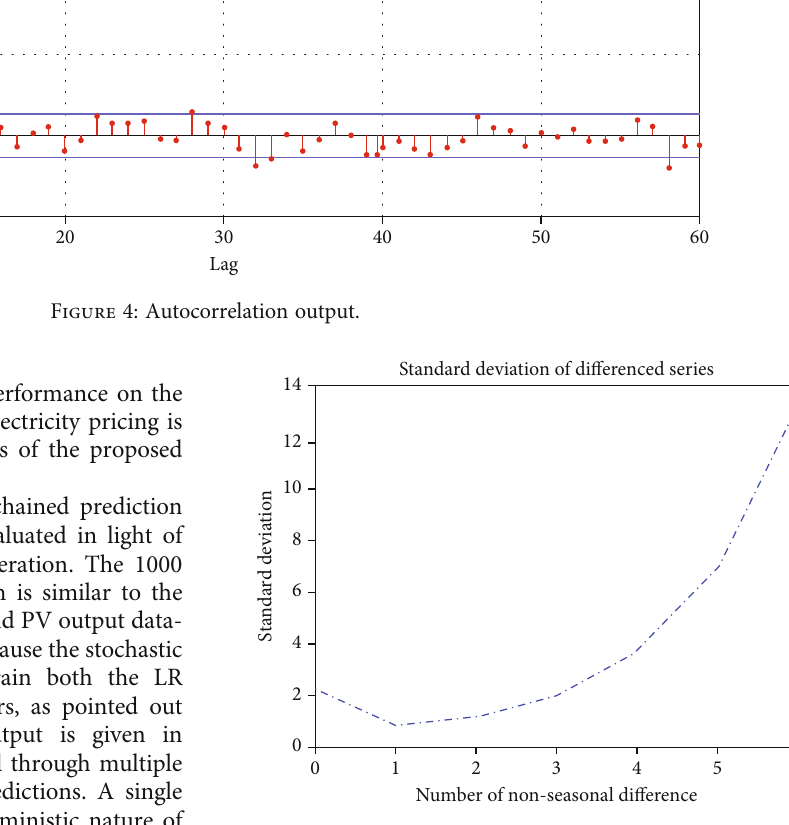
Figure 5: Standard deviation of